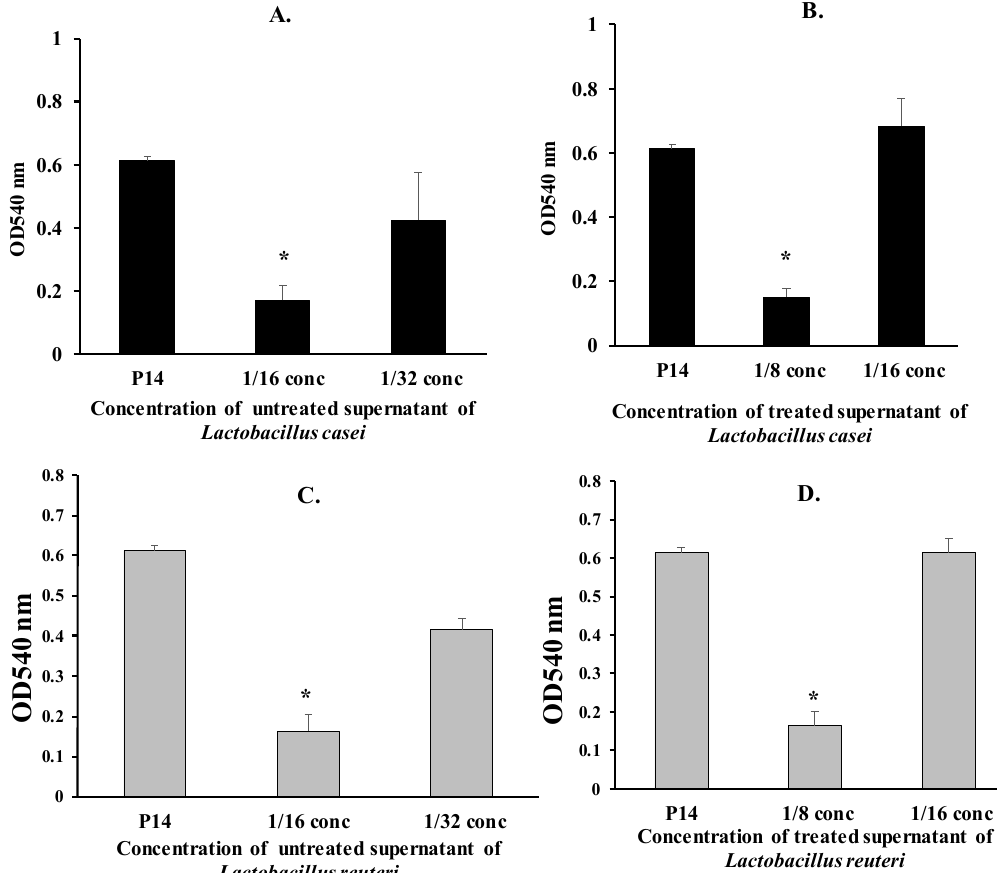
Figure 3. Adherence of the Proteus isolate P14 in the presence of supernatants of L. casei and L. reuteri (* p < 0.05). ( A ) Adherence of the Proteus isolate P14 in the presence of untreated supernatants of L. casei (* p < 0.05). ( B ) Adherence of the Proteus isolate P14 in the presence of treated supernatants of L. casei (* p < 0.05). ( C ) Adherence of the Proteus isolate P14 in the presence of untreated supernatants of L. reuteri (* p < 0.05). ( D ) Adherence of the Proteus isolate P14 in the presence of treated supernatants of L. reuteri (* p < 0.05).